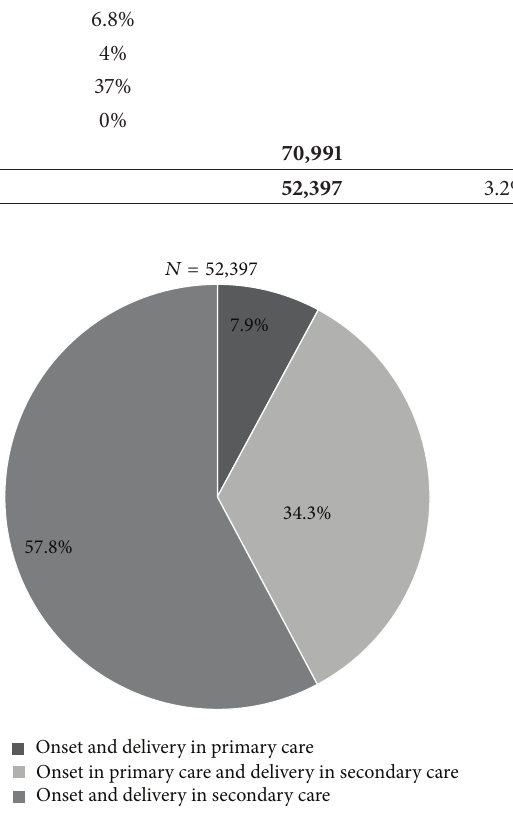
Figure 1: Study population (PTB 25 +0 –36 +6 ) divided by level of care at onset and